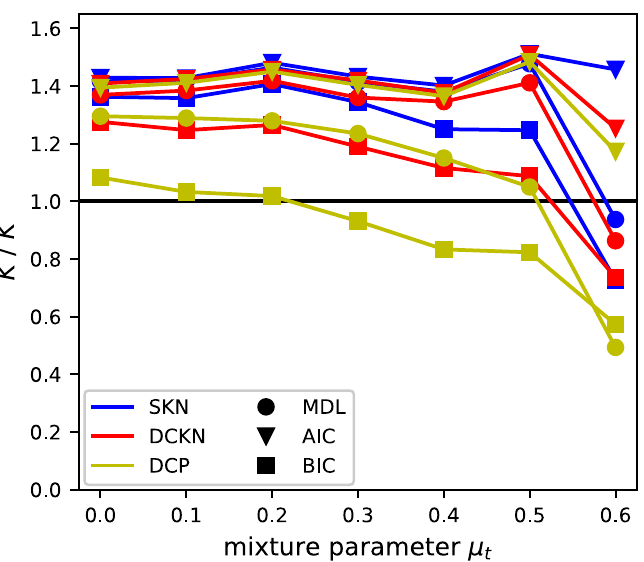
Fig 15. Ratio of average selected number of blocks � K to average true number of blocks K of the classical SBMs. As in Fig 16, the values shown are based on setting of Fig 17.